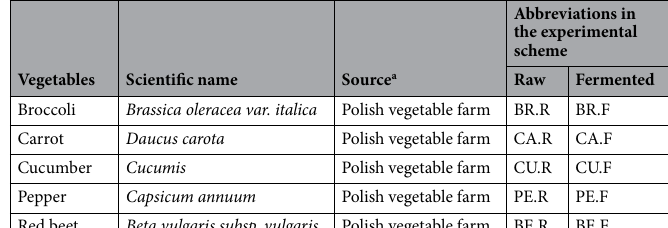
Vegetables Scientific name